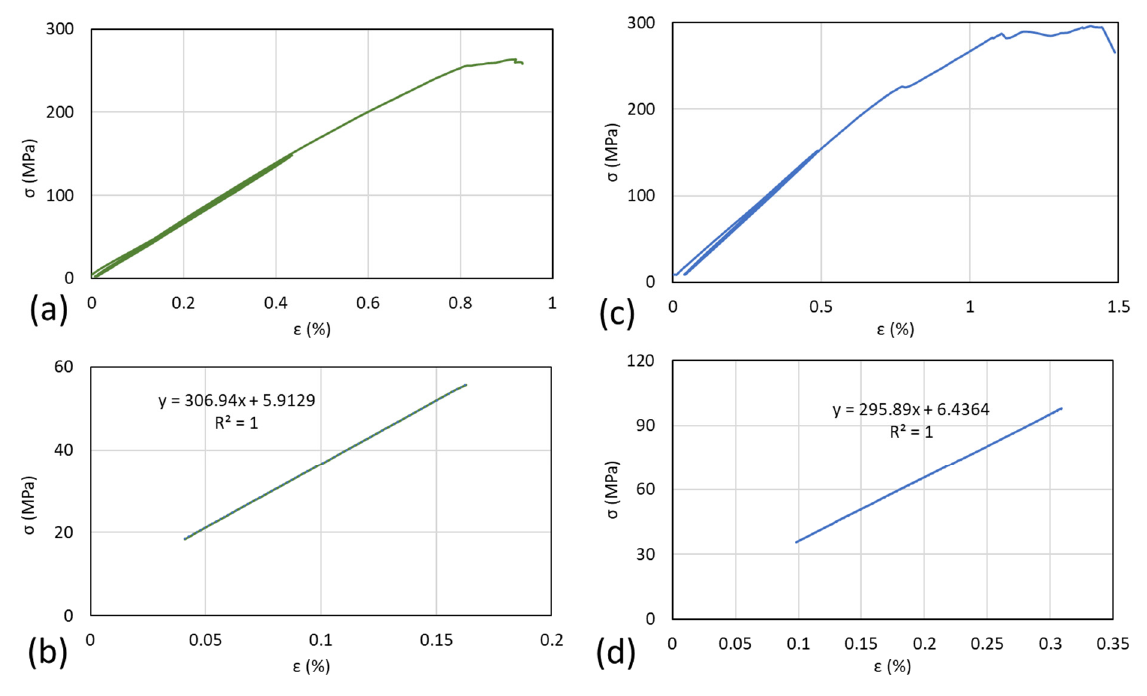
Figure 10. Stress–strain curves of the different samples. ( a ) and ( b ): [0/90] S specimen. ( c ) and ( d ): [90/0] S .